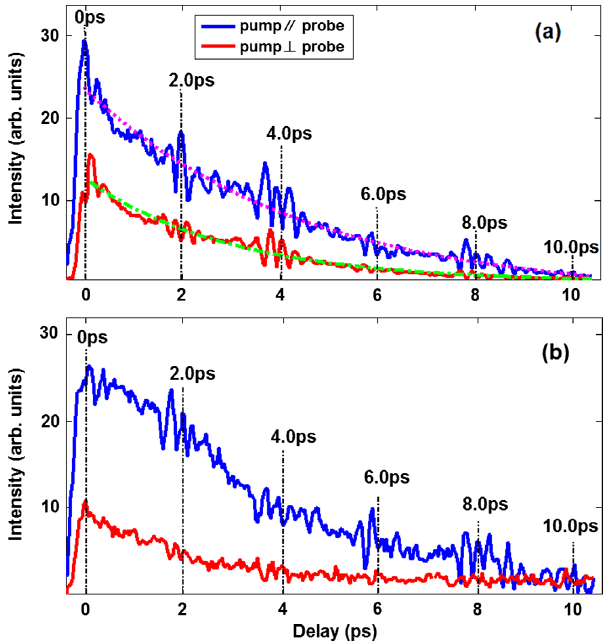
FIG. 2. The signal intensities of (a) the P -branch bandhead at around 391 nm and (b) the R -branch band recorded over the range of 387–390.7 nm as a function of the time delay between the pump and probe pulses for the parallel or perpendicular cases of the polarization directions of the two pulses. The dotted lines are the exponential fits of the experimental curves. The black dotted vertical lines indicate the revival times of N